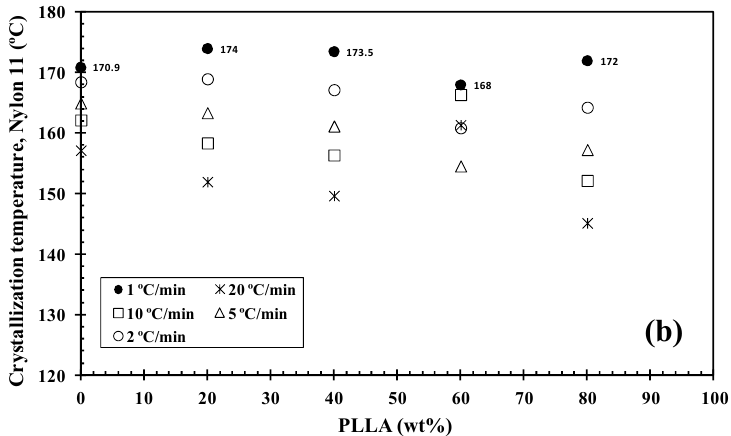
Figure 6. Variation in the PLLA/nylon 11-INT blend nanocomposite crystallization temperatures with ( a ) nylon 11 and ( b ) PLLA concentration.